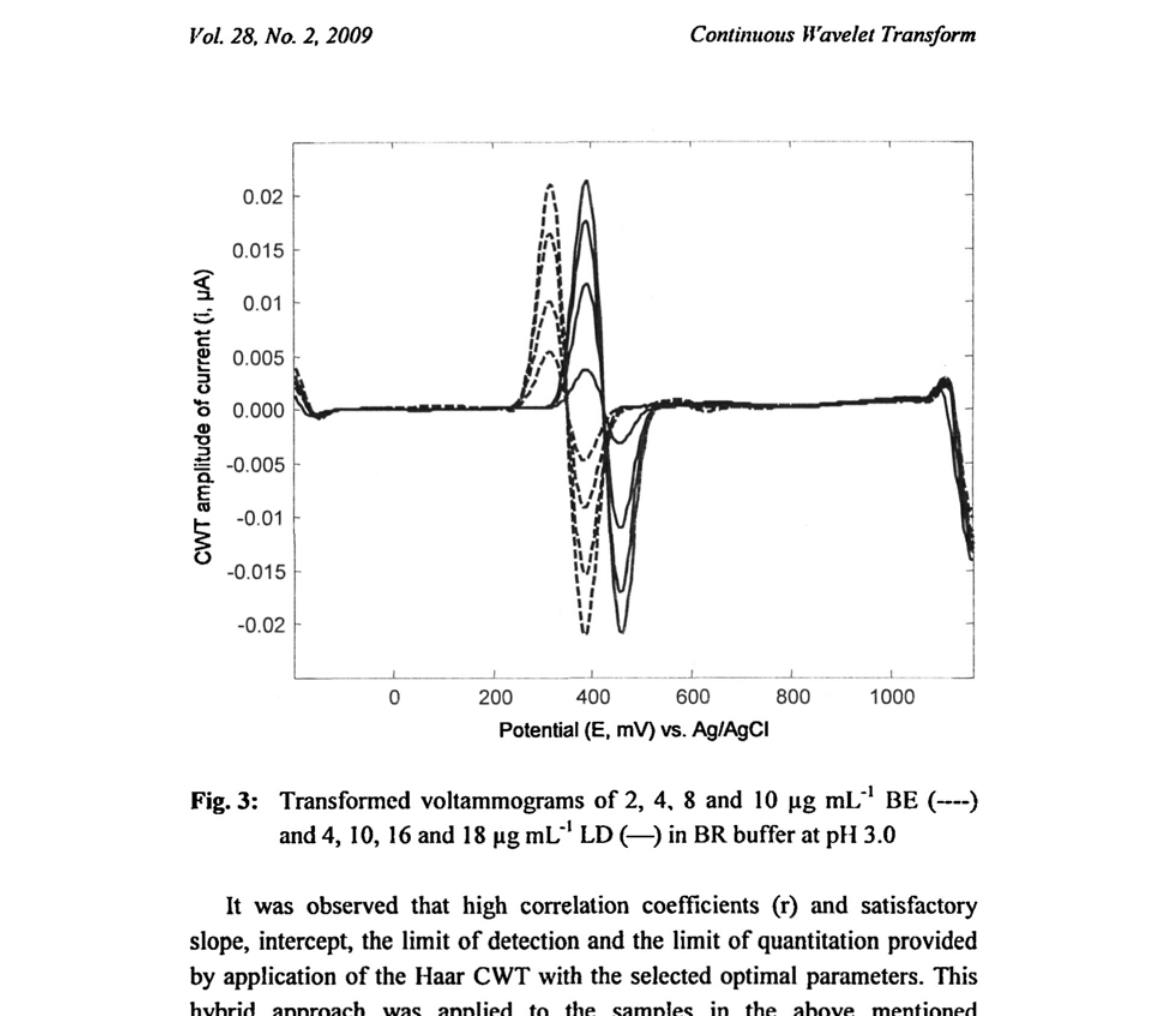
Fig. 3: Transformed voltammograms of 2, 4, 8 and 10 μ§ mL" 1 BE (—) and 4, 10, 16 and 18 μ§ ml/ 1 LD (—) in BR buffer at pH